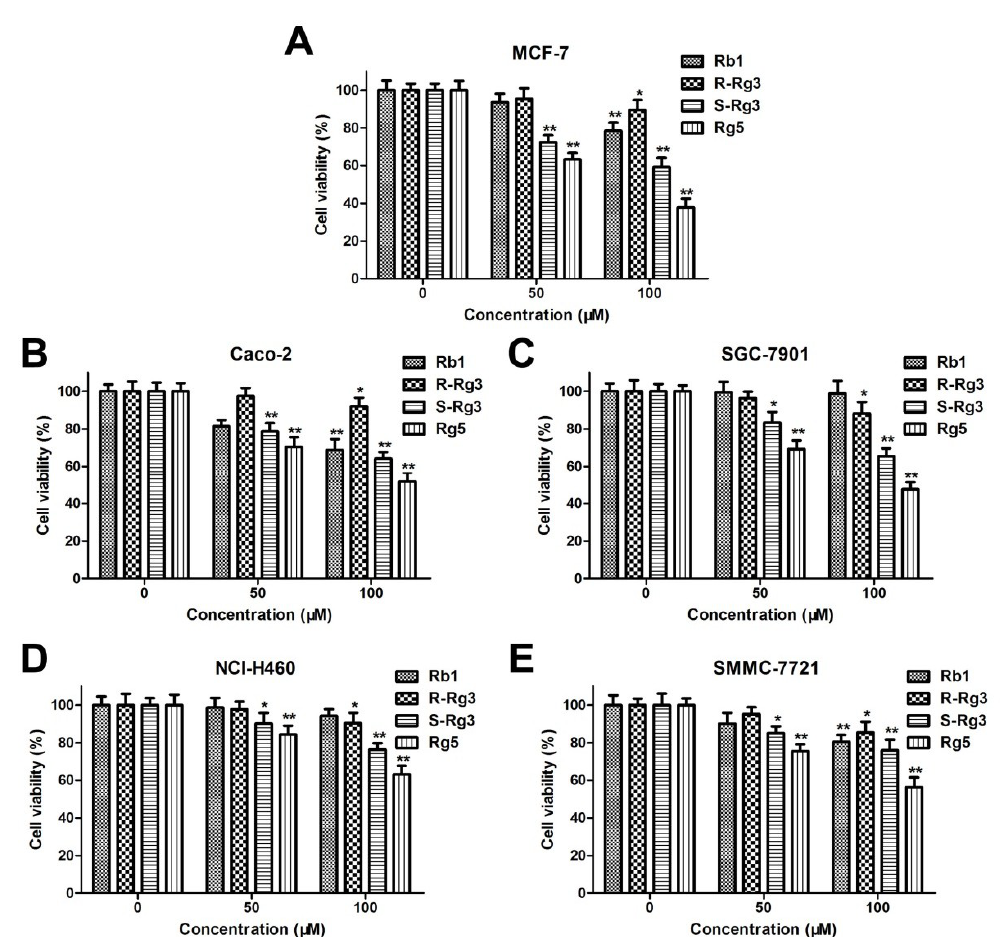
Figure 2. The cytotoxic effects of Rb1, R-Rg3, S-Rg3, and Rg5 on various human cancer cell lines: MCF-7 cells ( A ), CACO-2 cells ( B ), SGC-7901 cells ( C ), NCI-H460 cells ( D ), and SMMC-7721 cells ( E ). * P < 0.05 and ** P < 0.01 as compared with the control group.